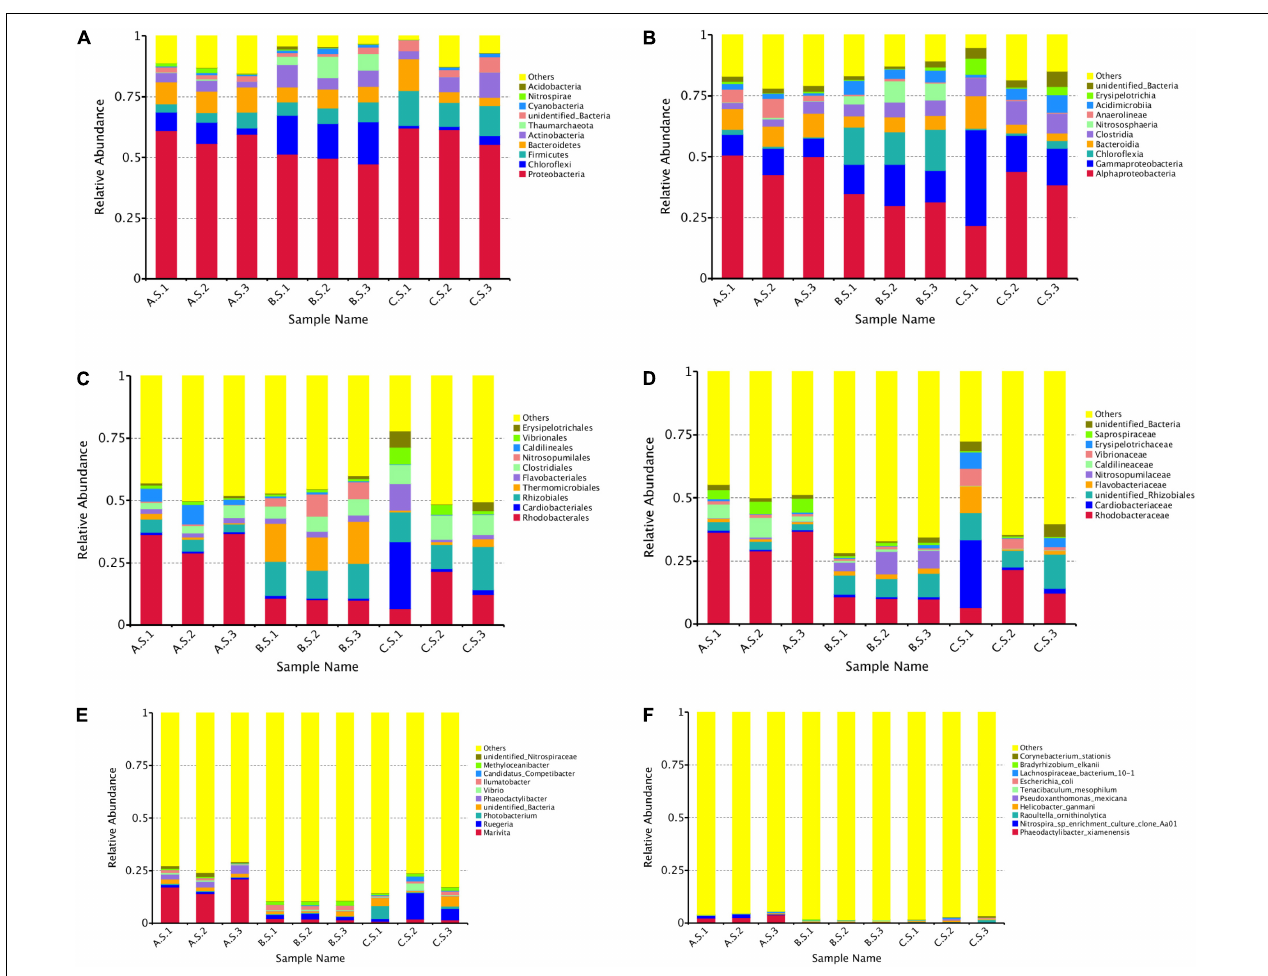
FIGURE 1 | Relative abundances of the dominant bacteria in each sample obtained from 16S rRNA gene sequencing (A) (phylum), (B) (class), (C) (order), (D) (family), (E) (genus), and (F) (species). AS, BS, and CS were water, biofloc, and intestinal samples of shrimp sampled from biofloc ponds. AS, water sample; BS, biofloc sample; CS, intestinal sample; 16S rRNA, 16S ribosomal